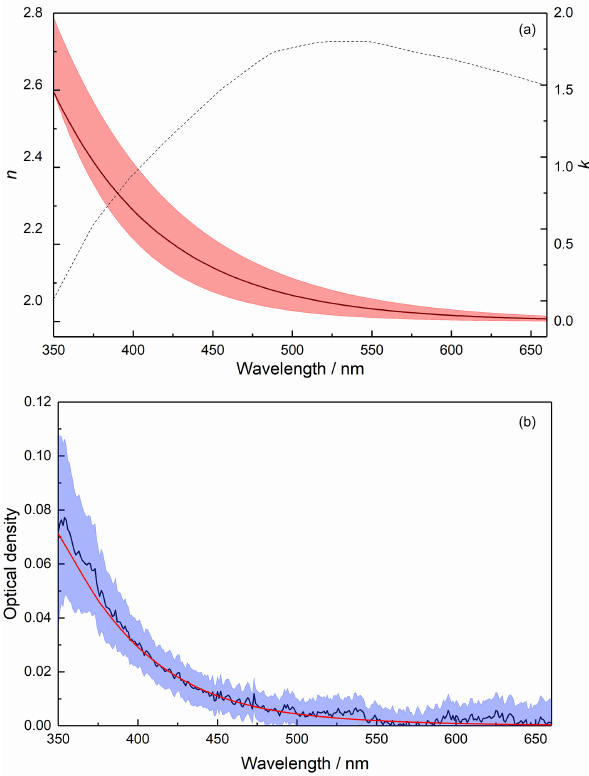
Figure 10. (a) Real ( n ) and imaginary ( k ) RIs for maghemite par- ticles (dashed and solid lines, respectively) with the uncertainty in k indicated with red shading. (b) Experimental OD (blue) and the calculated OD (red) using the wavelength-dependent RIs for maghemite